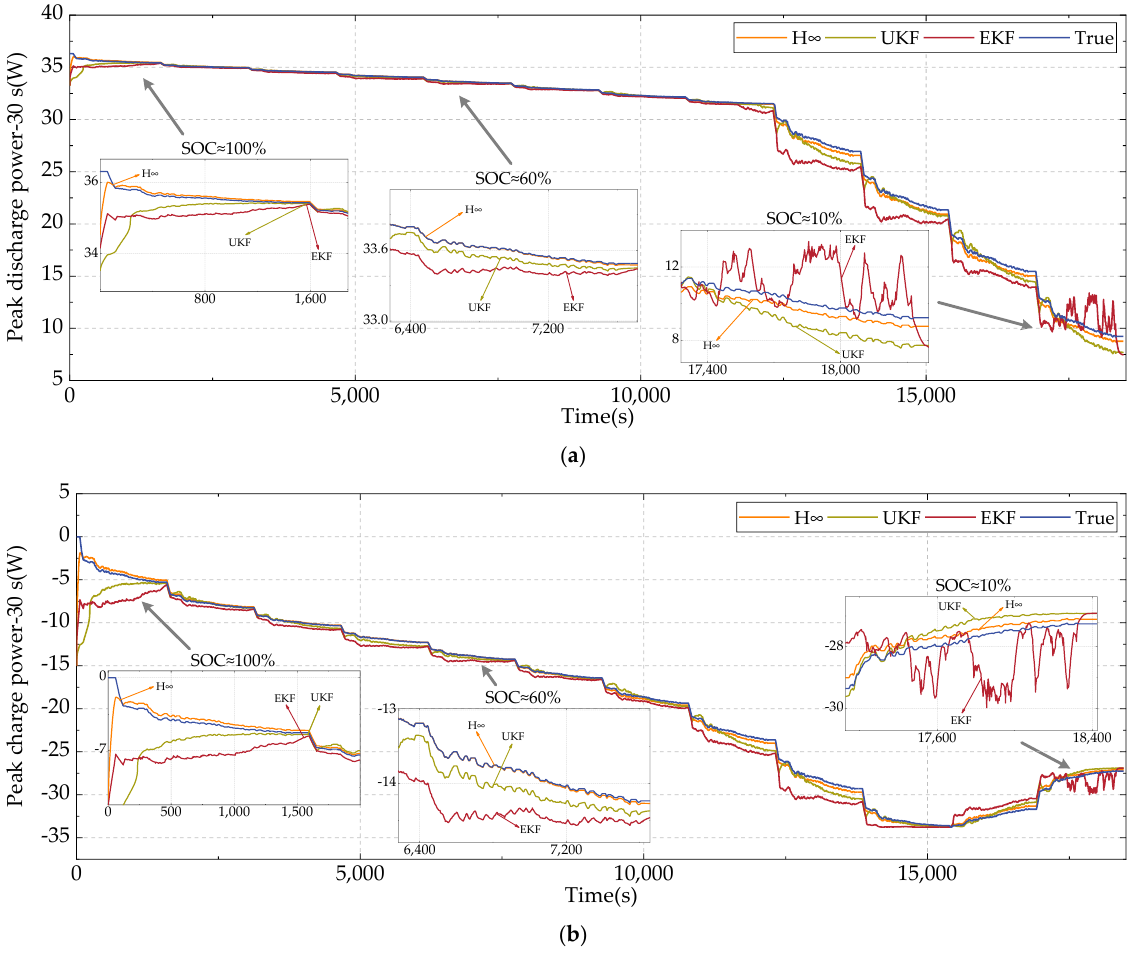
Figure 22. Comparison of charge and discharge SOP estimation based on H∞, UKF, and EKF algorithm to estimate SOC in 30 s time scale: ( a ) discharge; ( b ) charge. Table 3. Convergence time of charge and discharge SOP estimation of SOC based on H∞, UKF, and EKF algorithm in 30 s time scale.